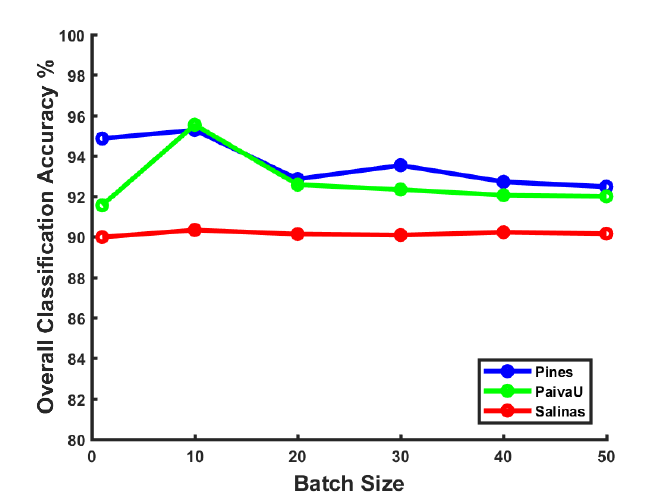
Figure 4. Batch size influence on training the SPPF framework ( CNN 2 -lite) with different